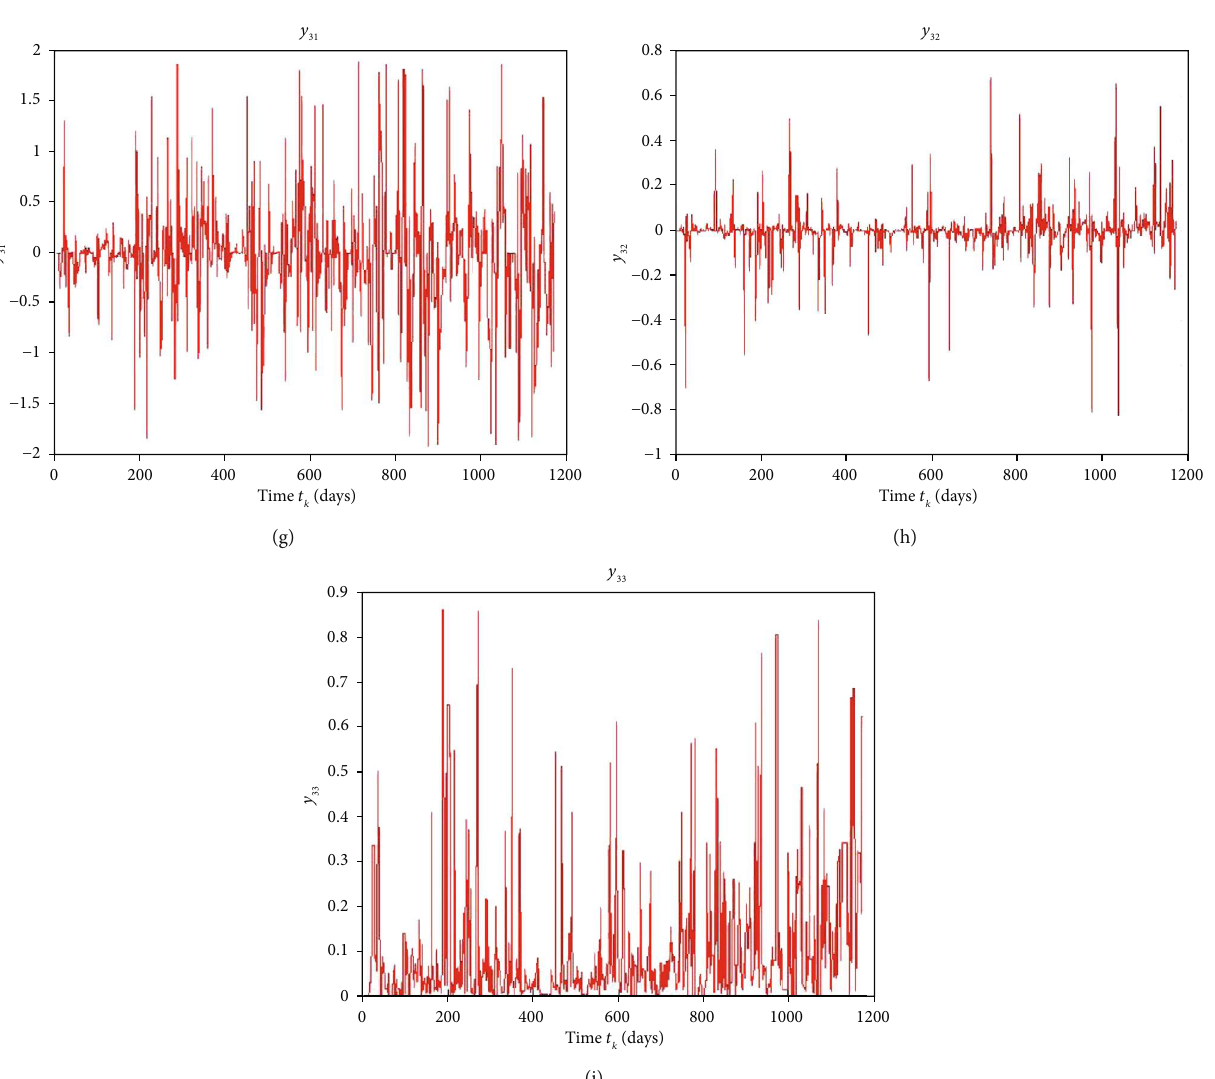
ð ̂ m , k Þ , γ k 1,1